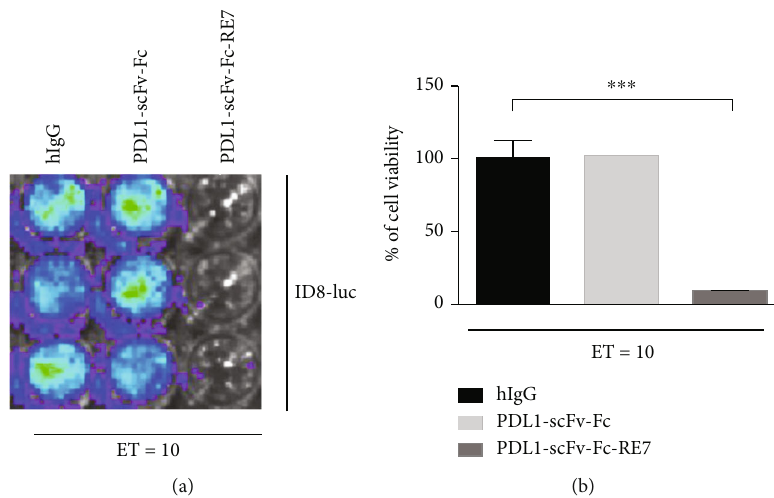
Figure 4: Characterization of the CTL-mediated killing of ID8-luc tumor cells incubated with the various chimeric proteins. (a) Representative luminescence imaging of in vitro E7-speci fi c CTL killing of luciferase-expressing ID8-luc cells. ID8-luc cells were preincubated with 5 μ g/mL PD-L1-scFv-Fc, PD-L1-scFv-Fc-RE7, or hIgG. Pretreated cells were then incubated with E7-speci fi c CD8+ T cells ( E / T = 10/1 ). CTL-mediated tumor cell death was determined by decreasing luminescence activity. (b) Bar graph depiction of tumor cell viability after treatment with PD-L1-scFv-Fc, PD-L1-scFv-Fc-RE7, or hIgG protein ( mean ± SD ) (data representative of three experiments).